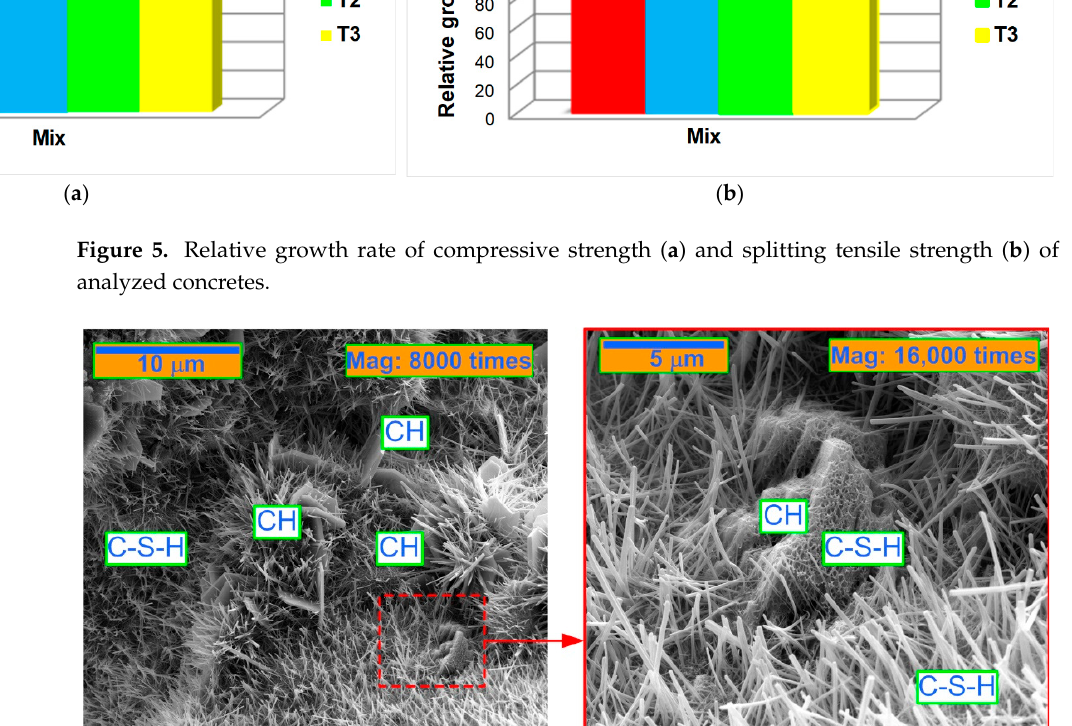
Figure 6. SEM microimages of analyzed REF concrete; descriptions in the text.